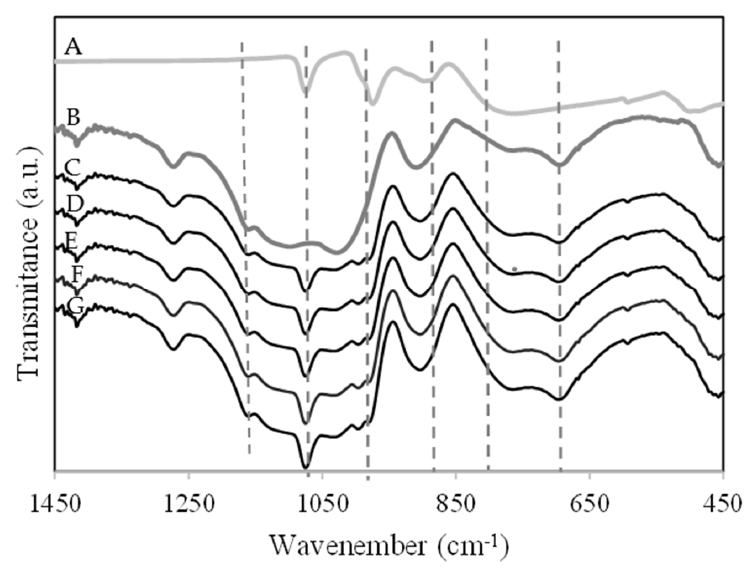
Figure 3. ATR‑FTIR spectra of the catalysts: ( A ) PW; ( B ) SBA‑15‑SO 3 H; ( C ) PW1‑SBA‑15‑SO 3 H, ( D ) PW2‑SBA‑15‑SO 3 H, ( E ) PW3‑SBA‑15‑SO 3 H, ( F ) PW4‑SBA‑15‑SO 3 H, ( G ) PW5‑SBA‑15‑SO 3